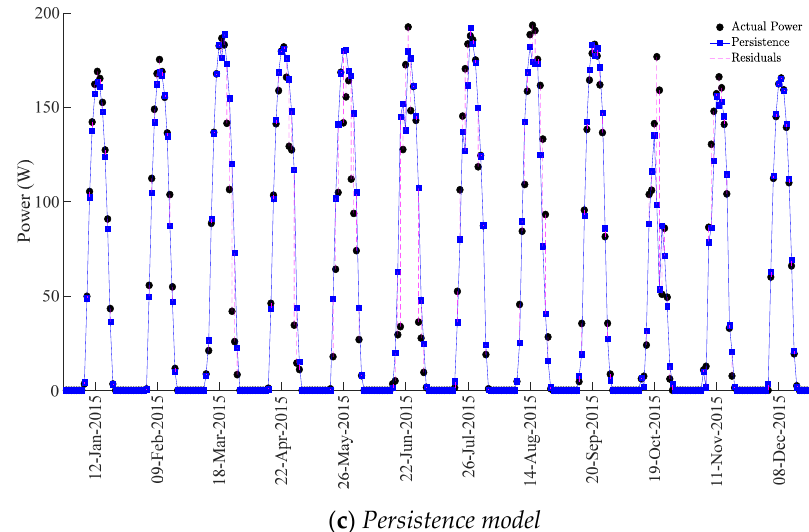
Figure 13. Comparison of real active power versus forecasting models. Table 12. Results of performance tests.